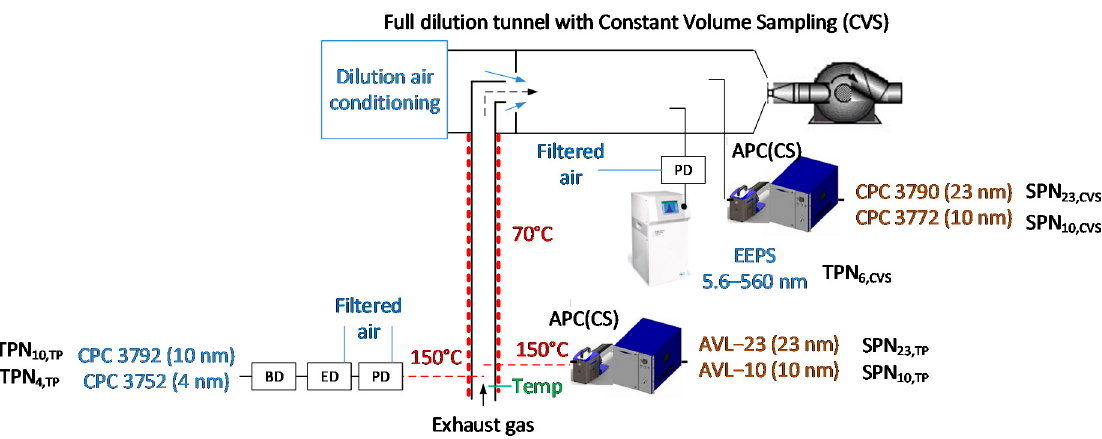
Figure 1. Schematic setup. APC = advanced particle counter; BD = bifurcated diluter; CPC = condensation particle counter; CS = catalytic stripper; CVS = constant volume sampling; EEPS = engine exhaust particle sizer; ED = ejector diluter; PD = porous diluter; SPN = solid particle number; Temp = temperature; TP = tailpipe; TPN = total particle